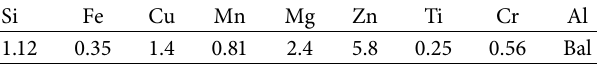
Table: 1: Composition for aluminium alloy